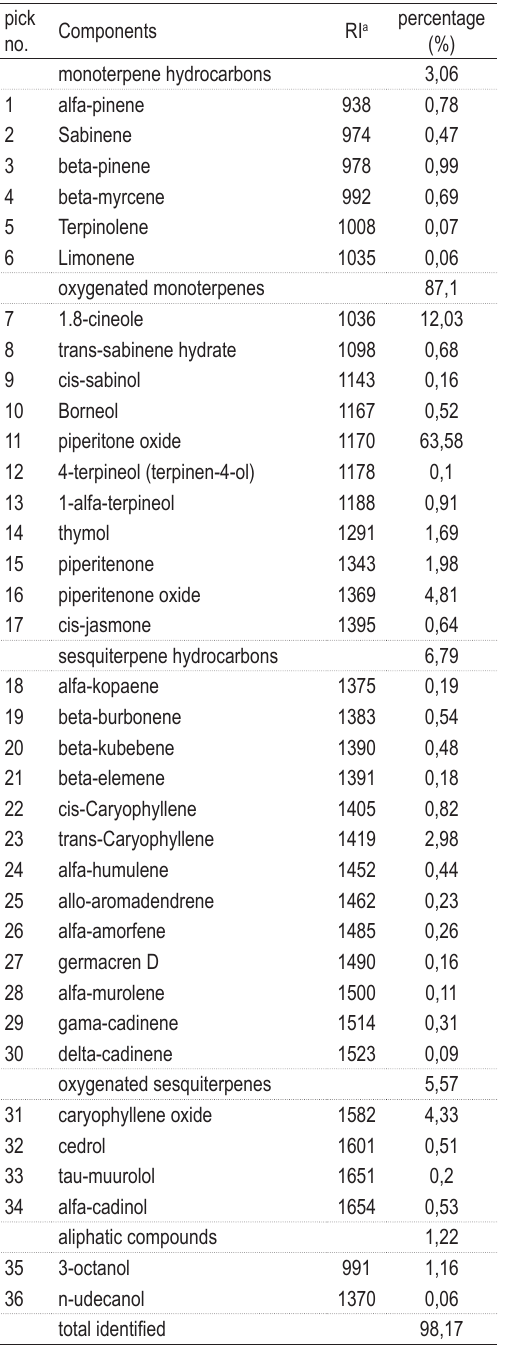
TABLE 1. Chemical Composition of M. longifolia Essential Oil